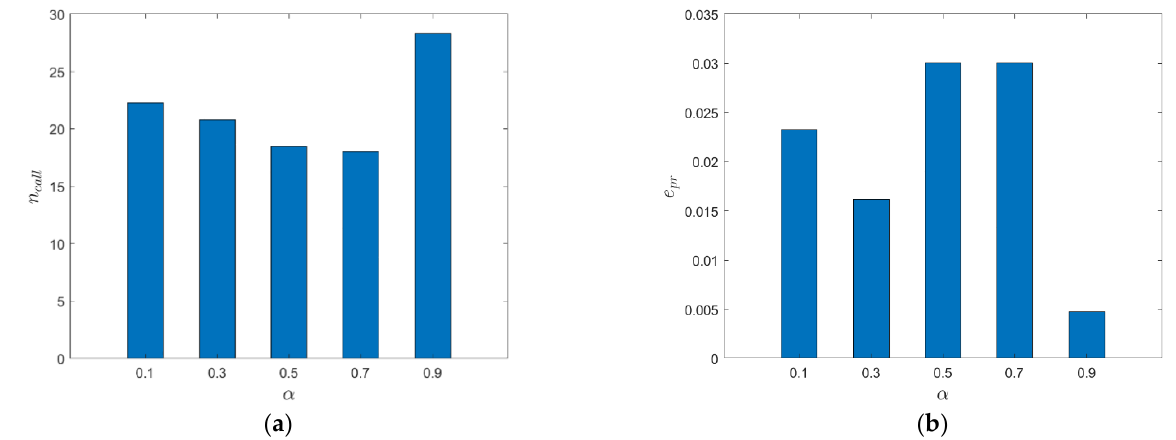
Figure 5. The mean n call and e pr of the predictions with different α . ( a ) mean n call with different α . Figure 5. The mean c a ll n and p r e of the predictions with different  . ( a ) mean c a ll n with ( b ) mean e pr with different α different  . ( b ) mean p r e with different  .